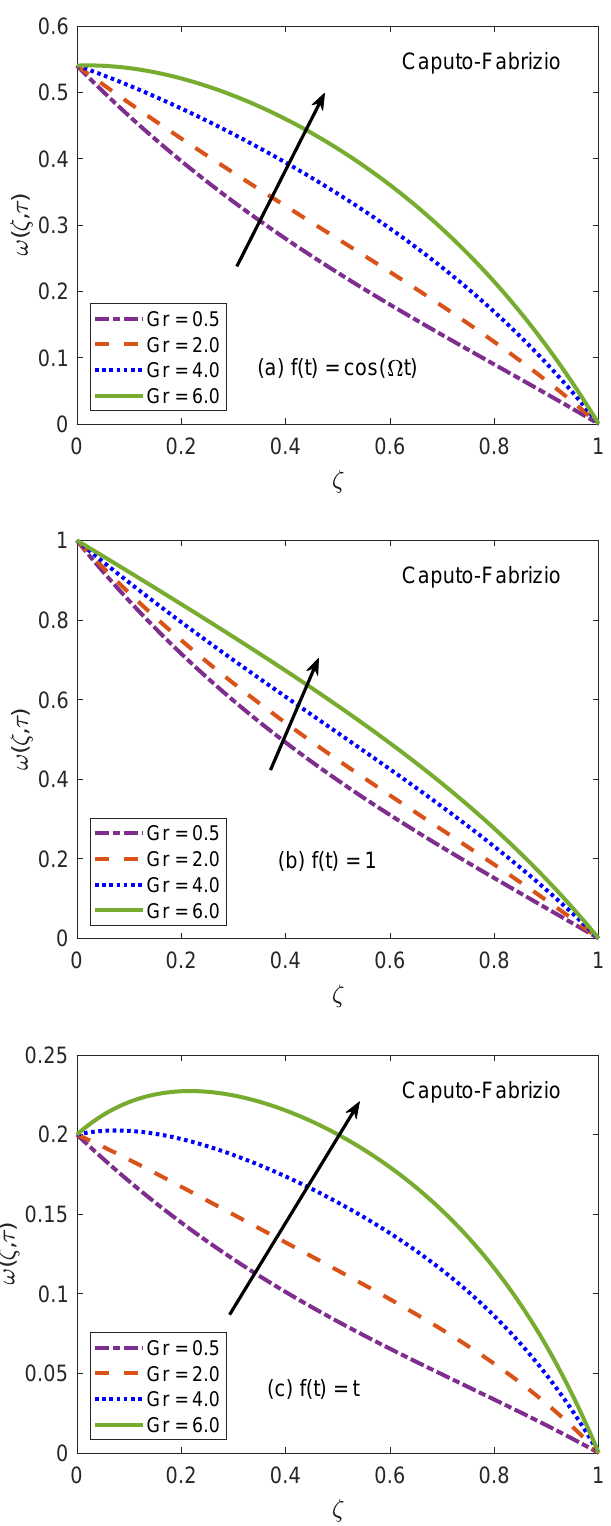
Figure 13. Velocity patterns for variation of Gr